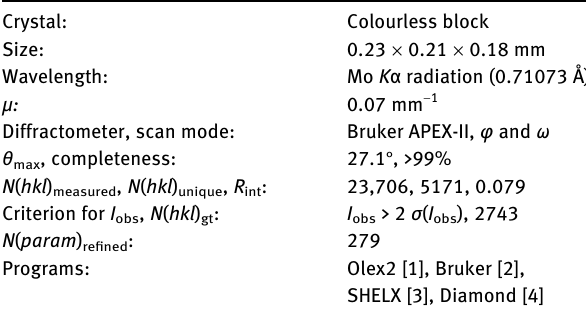
Table  : Data collection and